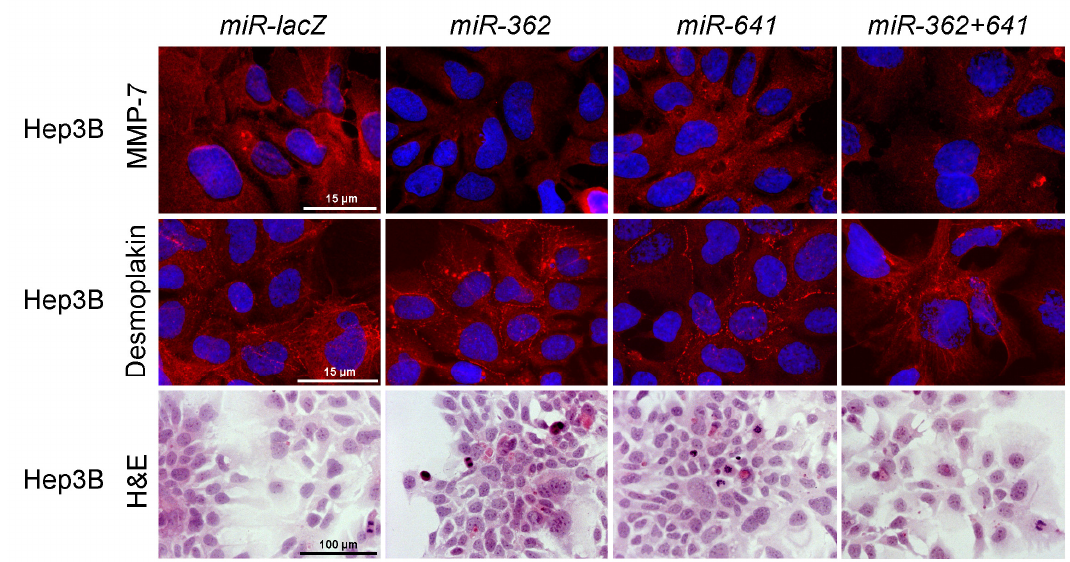
Figure 9. Changes in cell morphology upon Ets-1 silencing. With regard to inhibition of MMP-7 and di ff erentiation, miRNAs targeting Ets-1 failed to fully replicate the changes observed after syndecan-1 transfection. The miR-641 did not inhibit the expression of MMP-7 and only modest desmoplakin relocalization was detected. H&E staining showed very few di ff erentiated cells throughout the various transfectants. Representative images are at 1000 × magnification (scale bar 15 µ m) and 200 × magnification (scale bar 100 µ m).